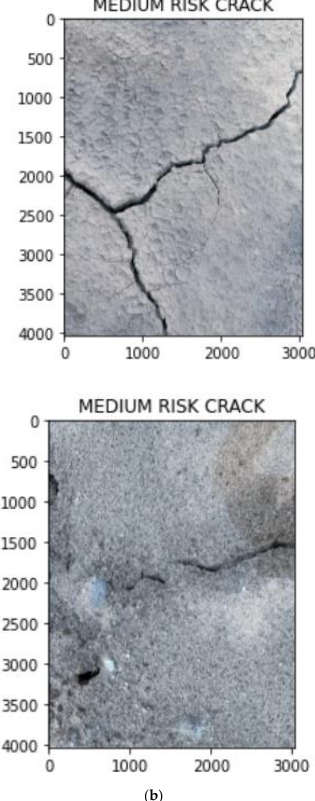
Sensors 2023 , 23 , x FOR PEER REVIEW Figure 13. ( a,b ) Sample output images from the model classified as “Medium -R isk Crack”. Figure 13. ( a,b ) Sample output images from the model classified as “Medium-Risk Crack”.